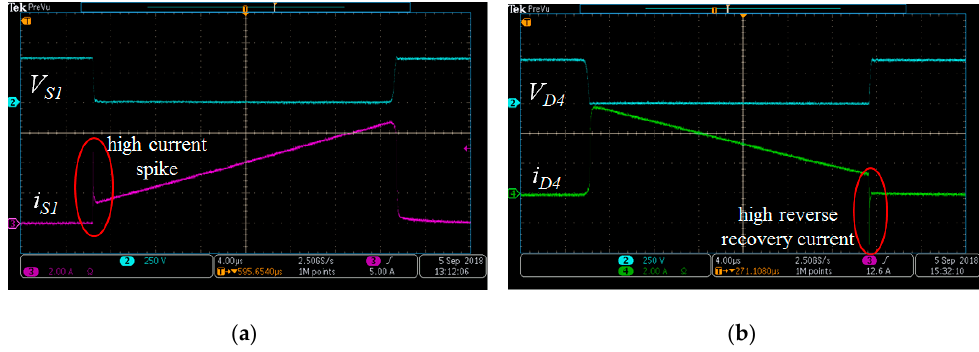
Figure 11. Experimental waveforms of the conventional inverter: ( a ) V S1 and i S1 ; ( b ) V D4 and i D4 .